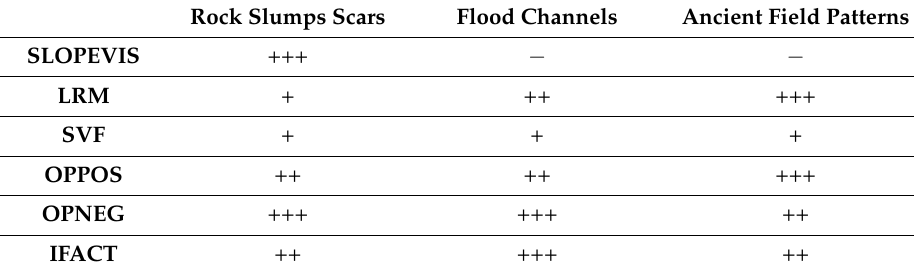
Table 2. Estimated performance of VTs in selected areas. Qualitative value representing the overall user impression is given by graduated symbols ( − to